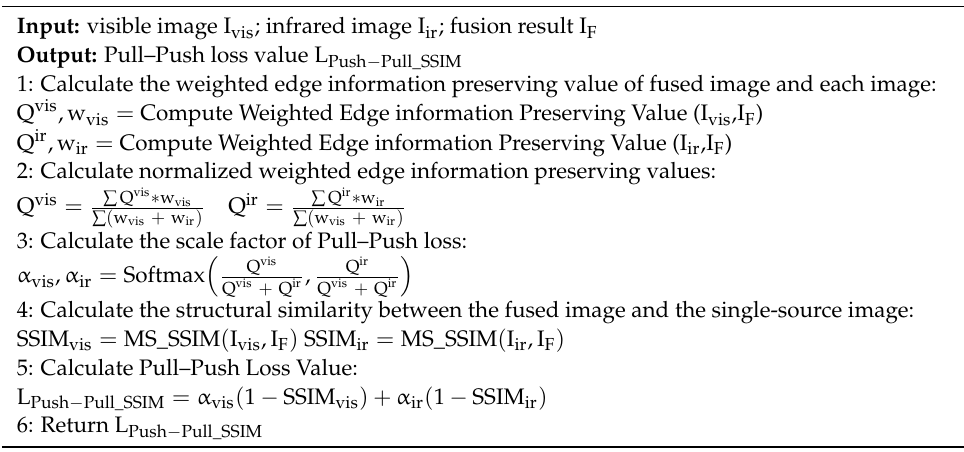
Algorithm 2 Compute Pull–Push Loss